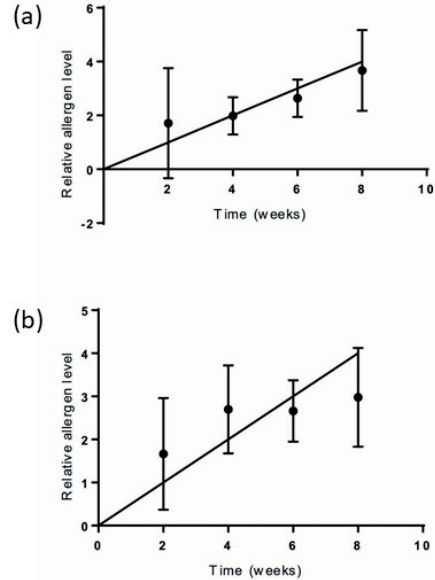
Figure 1. Relative allergen level increase in electrostatic dustfall collectors (EDC) with increasing sampling duration: ( a ) mouse allergen; ( b ), rat allergen. The data points show relative allergen level. The bars show standard deviation.